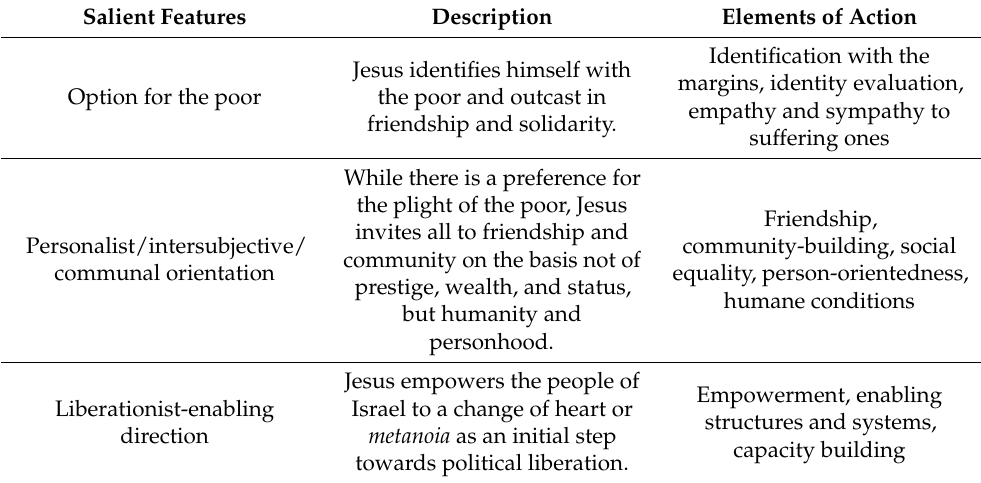
Table 1. Jesus’ praxis of compassion. Salient